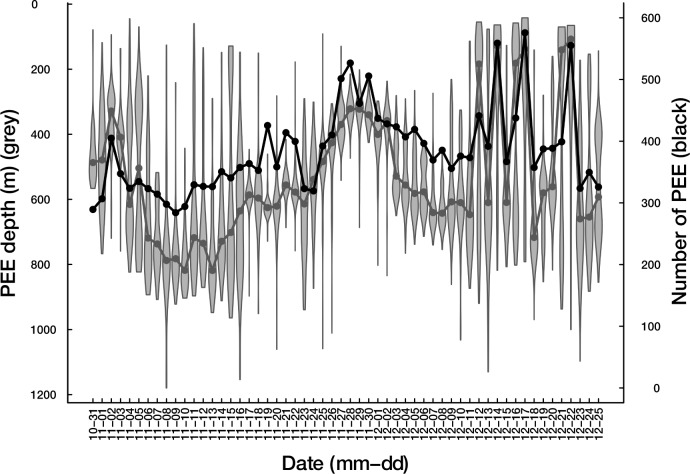
Time series of the vertical distribution of PEE in the bottom of dives and of the number of PEE rate (individual 2011–28).The black lines stand for the PEE rate (number of bottom PEE per day, daytime only), the grey violins for the vertical distribution of daytime bottom PEE (with median depth of daily PEE indicated by the grey dots).